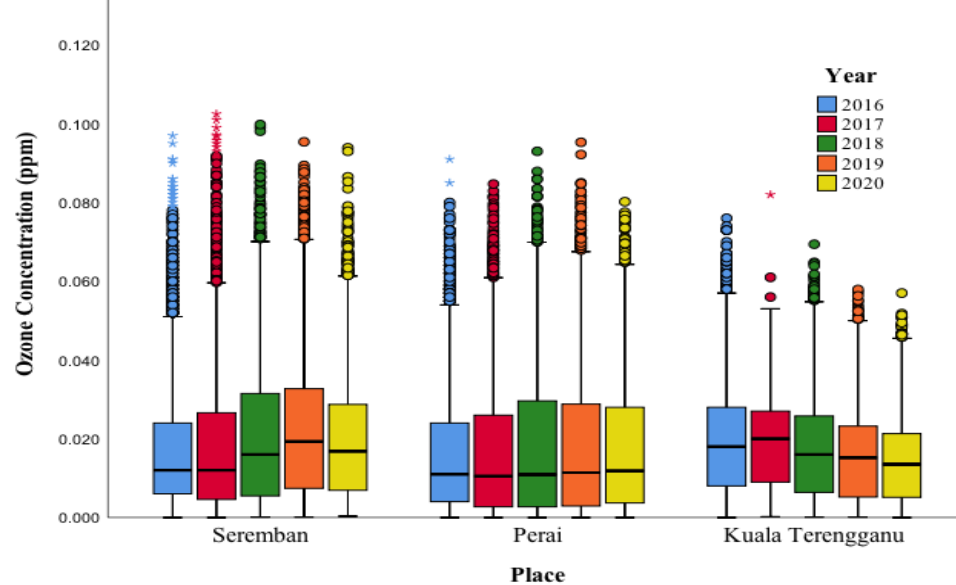
Figure 2. Hourly box plot of O 3 levels in Seremban, Perai, and Kuala Terengganu. The asterisk (*) on the boxplot indicate the extreme outlier that lie >1.5 times the size of the box.